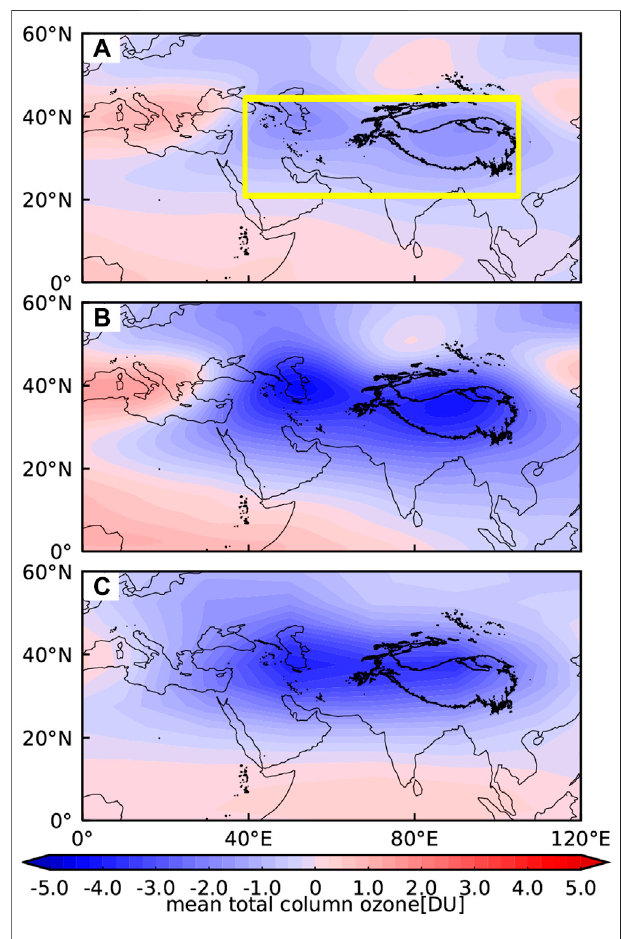
FIGURE 1 | The distribution of the TCO* (Unit: DU) averaged from 1984 to 2019 in summer from (A) ERA5, (B) MERRA2, (C) SWOOSH. The bold black contours denote the topography surpassing 3 km. The yellow box outlines the region from 40 ° E to 105 ° E and from 20 ° N to 45 °